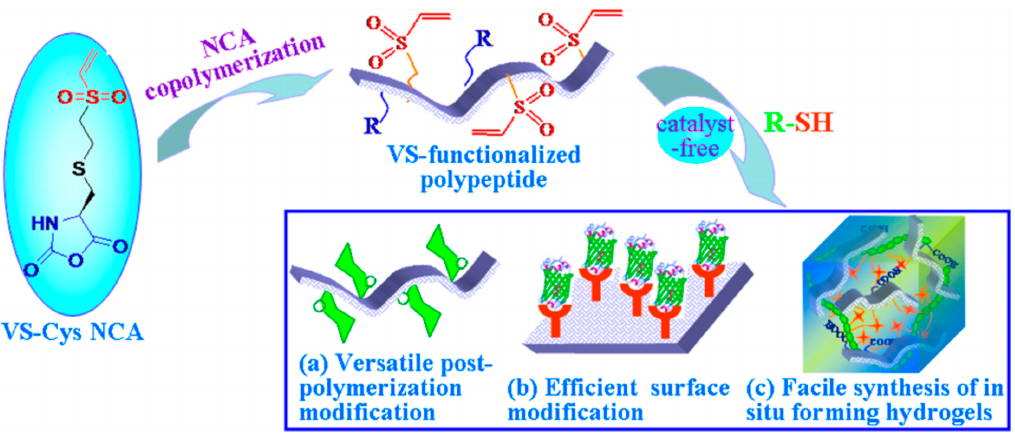
Figure 22. Poly(vinyl sulfone- L -cysteine) modified by Michael addition. Reproduced with permission from reference [92].